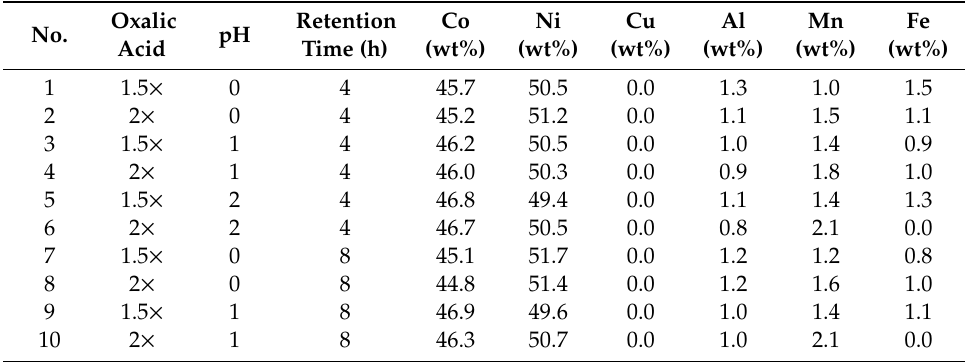
Table 4. Metal contents of the obtained mixed cobalt-nickel oxalates.